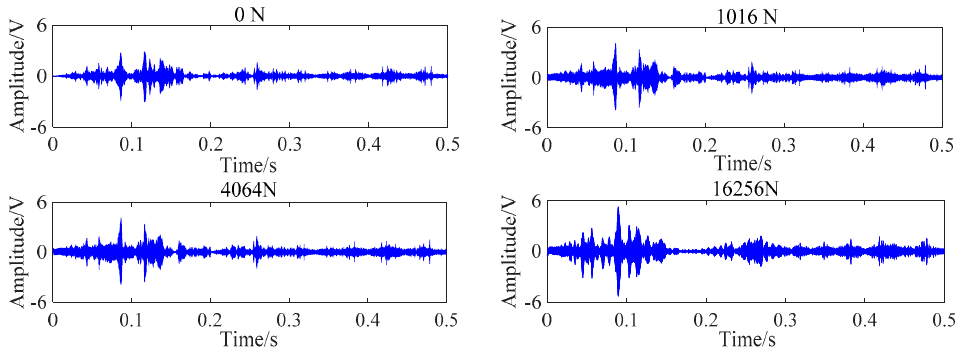
Figure 18. Received signal of PZT BA combination under four loading conditions.